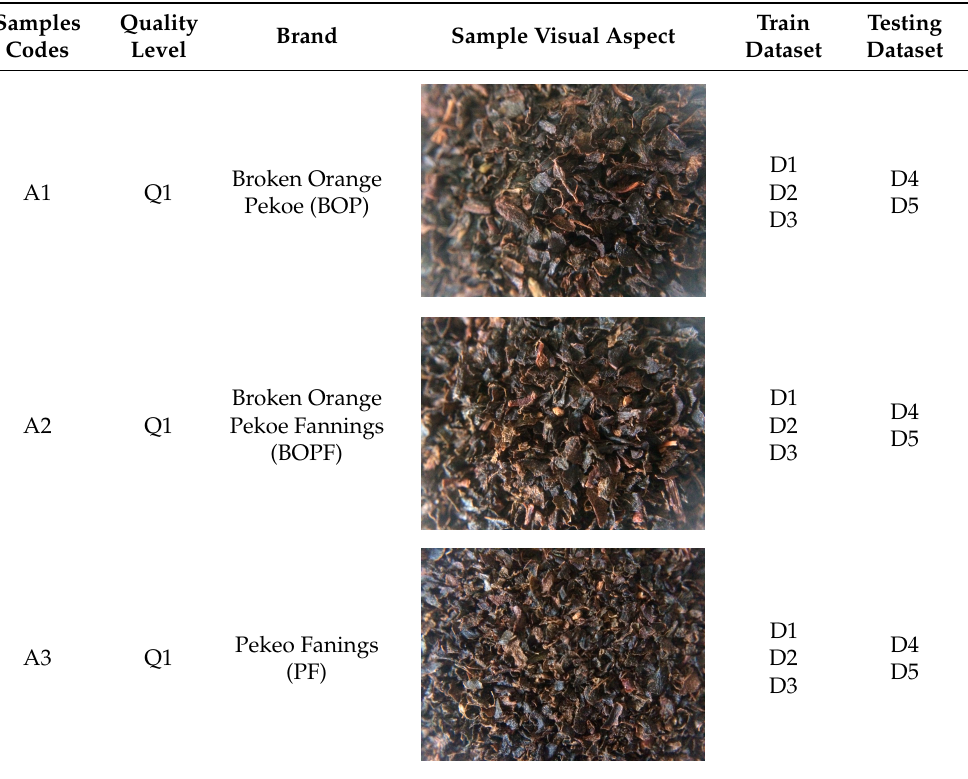
Table 1. List of dried black tea samples.